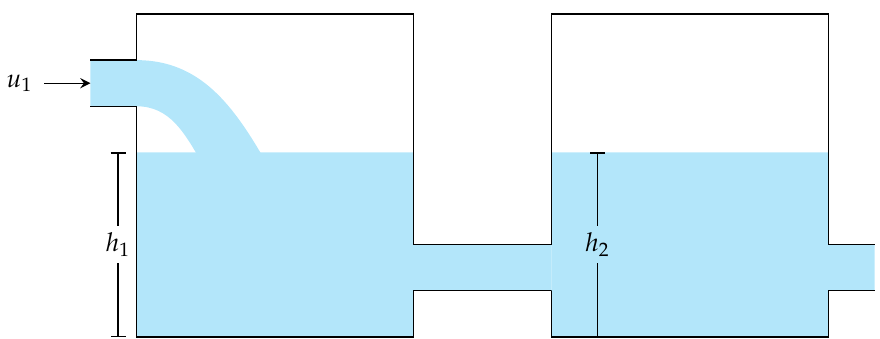
Figure 2. Coupled tanks model considered in the numerical example. The level on each tank h 1 , h 2 , measured independently from each other, are the system states, while the control input is the inlet flow u 1 into the first tank.